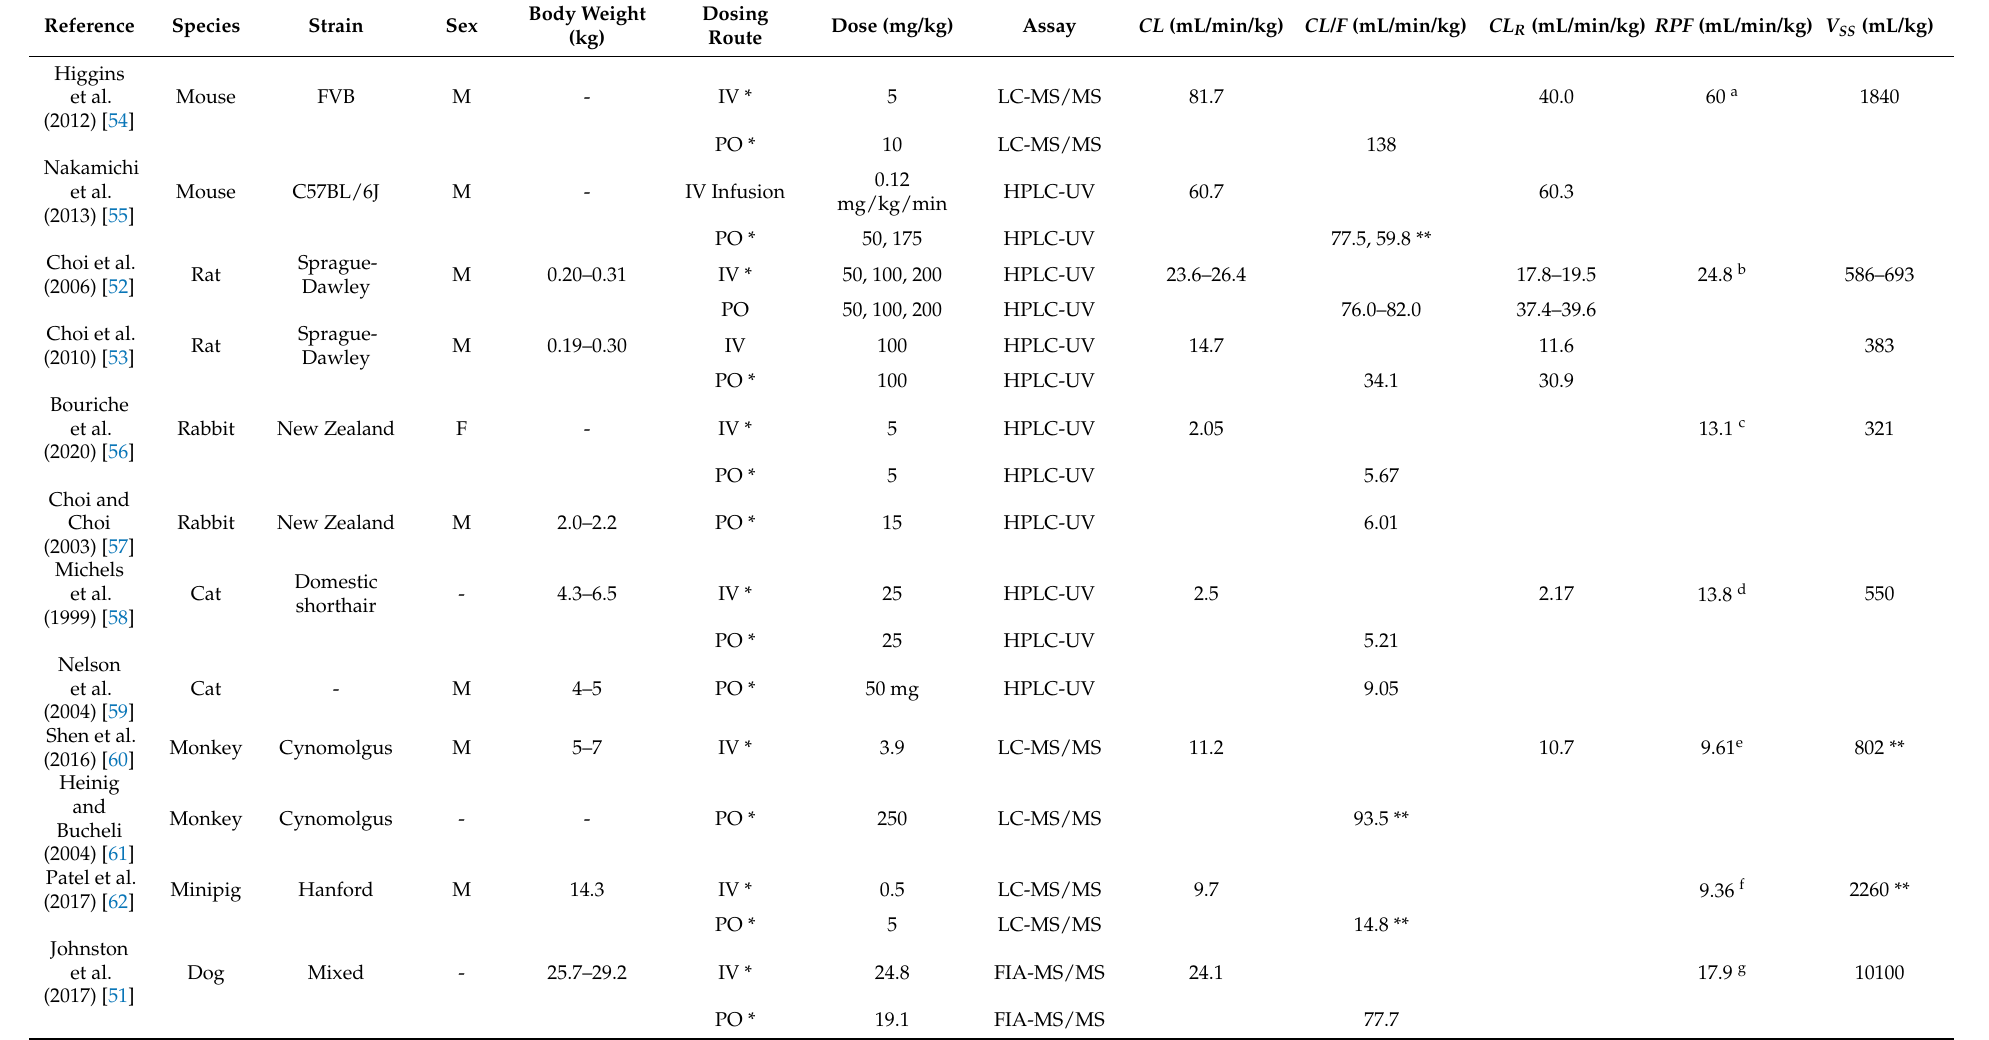
Table 1. Literature reports and pharmacokinetic parameters of metformin after intravenous and oral doses in various